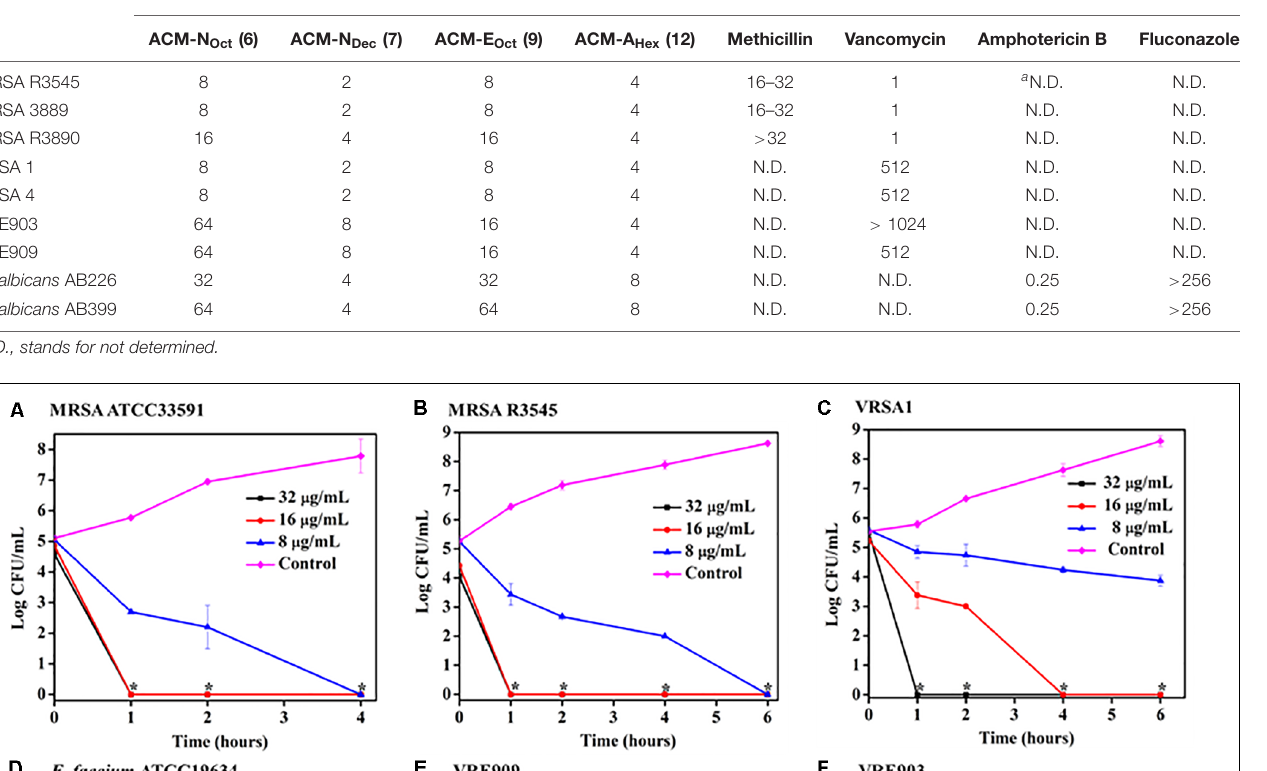
TABLE 2 | Antimicrobial activity of amphiphilic cationic macromolecules (ACMs) against clinical isolates of drug-resistant Gram-positive bacteria and fungi.